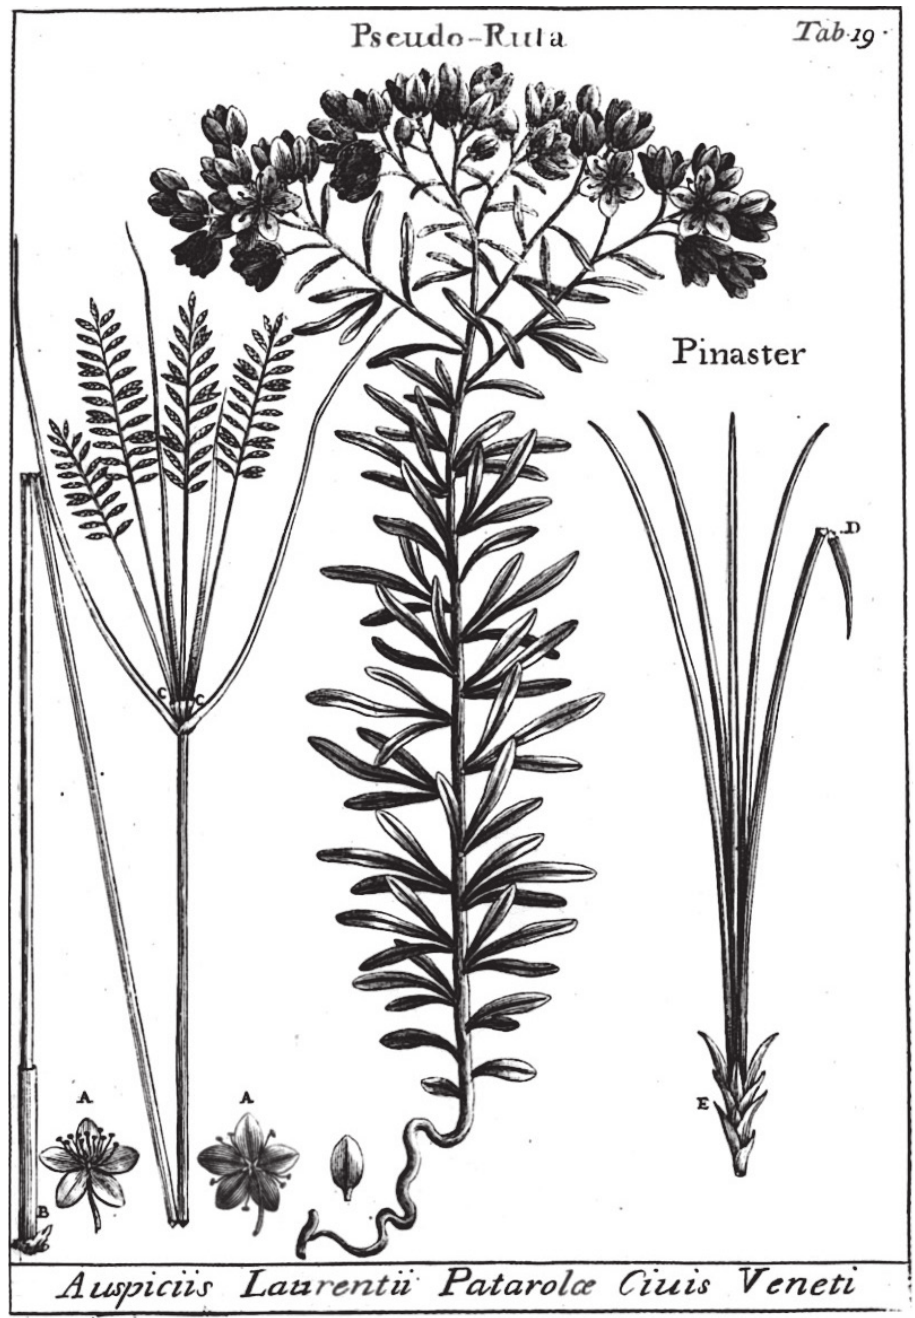
Figure 1. Iconography published in Nova Plantarum Genera (Micheli 1729) and designated as lectotype of Ruta patavina